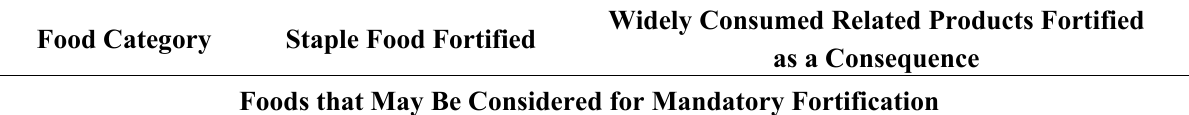
Table 1. Foods that may be suitable for fortification with vitamin D in